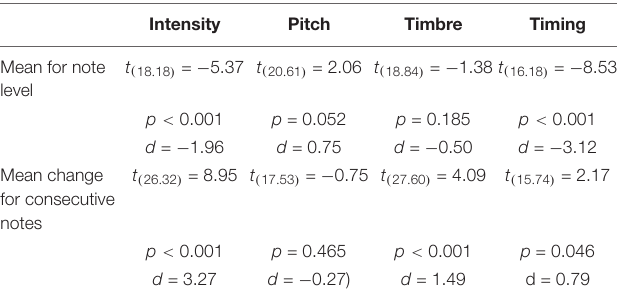
TABLE 1 | Output of the independent t -tests carried out for the four types of acoustic features (Intensity, Pitch, Timbre, and Timing) between music- and speech-like